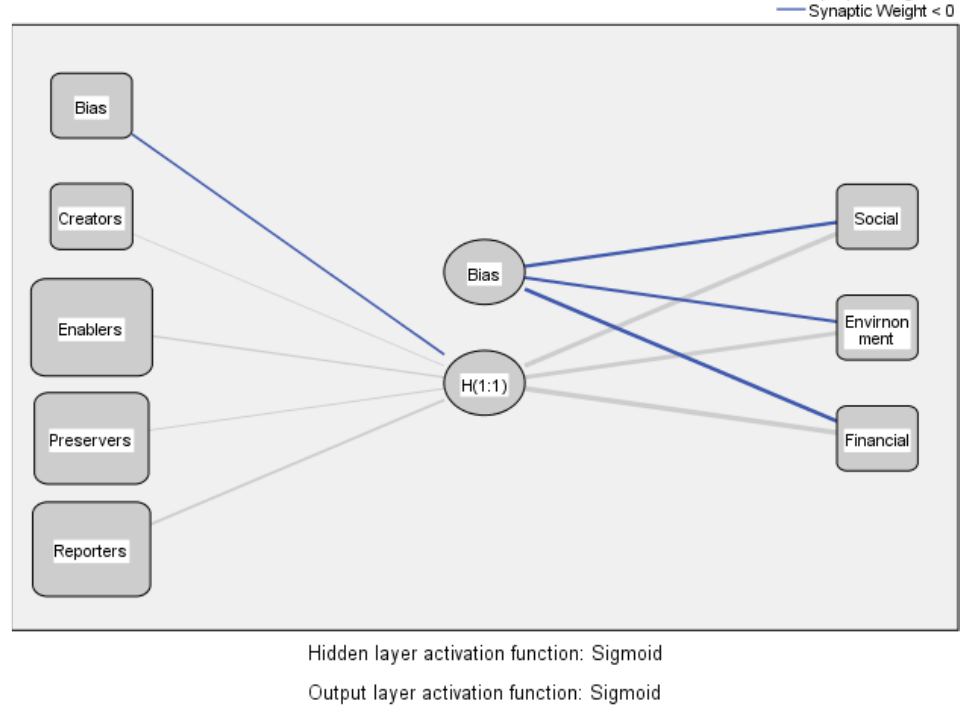
Figure 4. MLP model. Source: the authors’ design using SPSS v.20. Table 3. MLP model predictors.